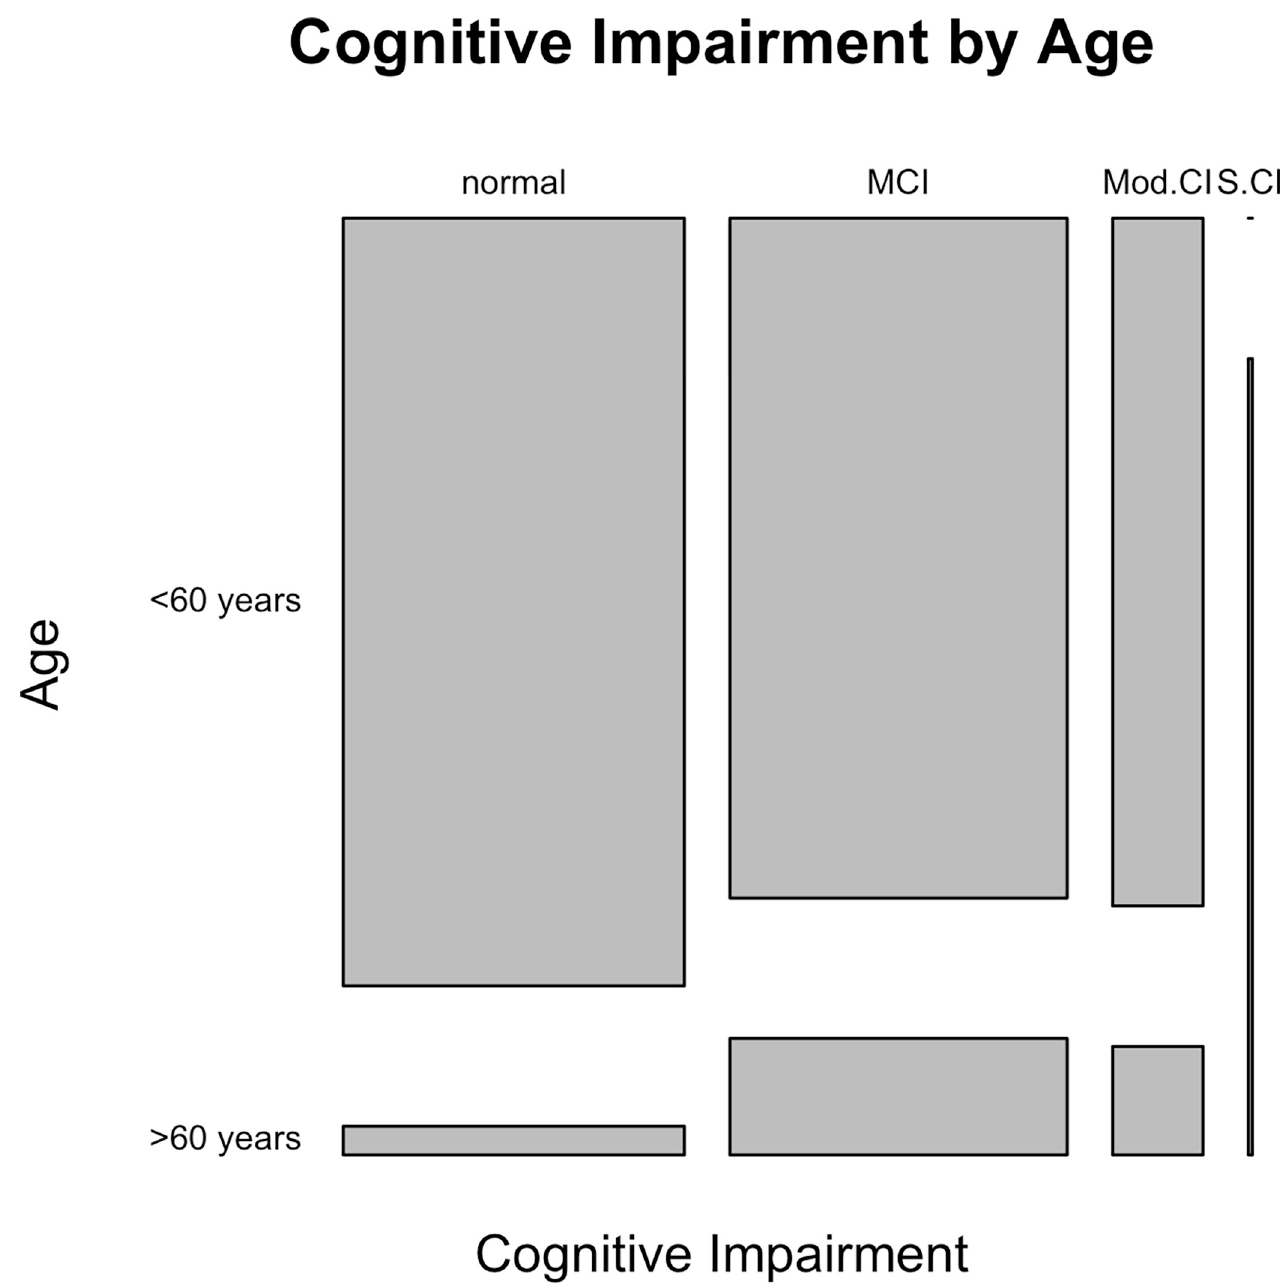
Fig 1. A mosaic plot of cognitive function by age. MCI—mild Cognitive Impairment; Mod. CI—Moderate Cognitive Impairment; S.CI—Severe Cognitive Impairment.